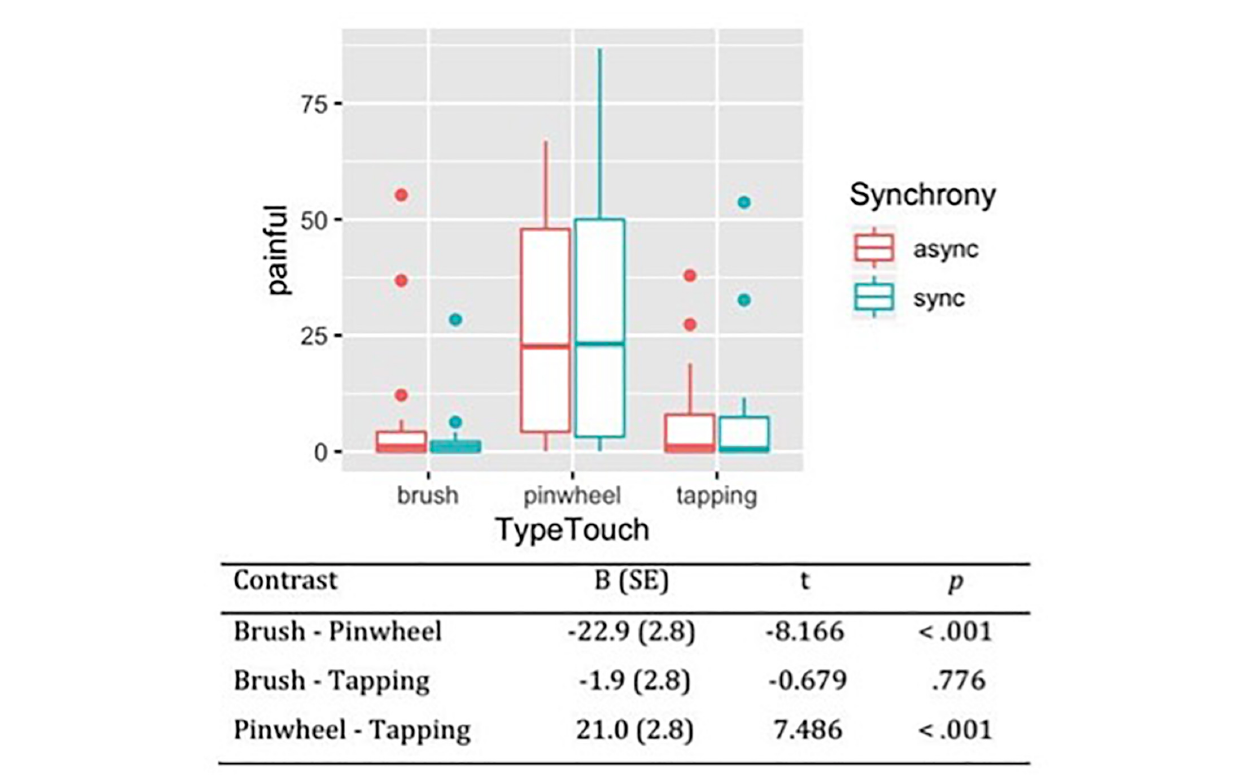
FIGURE 3 | Subjective pleasantness of tactile stimulations measured on VAS scale from 0 (not at all painful) to 100 (extremely painful). Contrasts between different types of touch have been reported, showing that rubbing with a pinwheel was perceived as the most painful